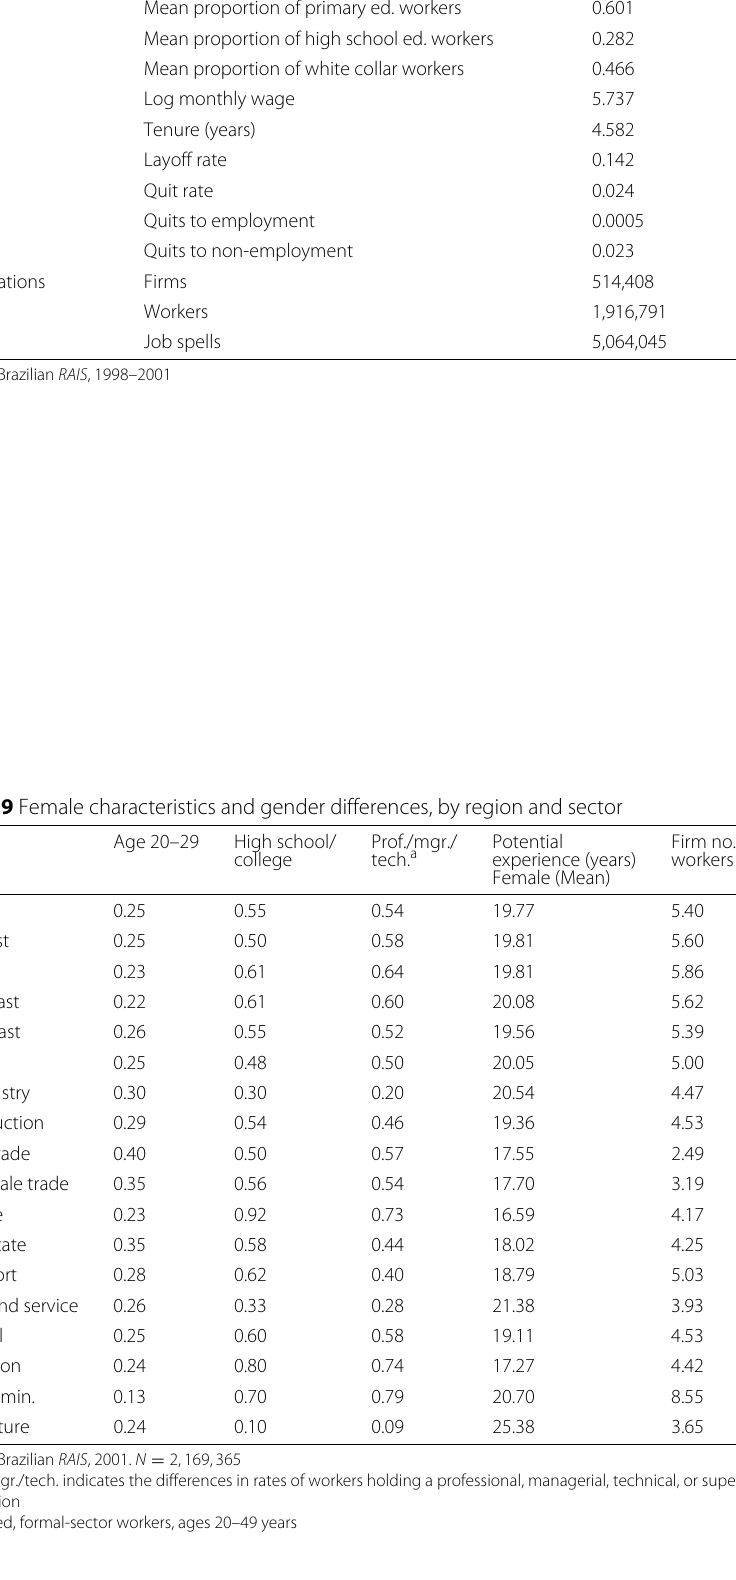
Table 8 Descriptive statistics of male and female formal-sector workers ( Continued ) Firms Log workers